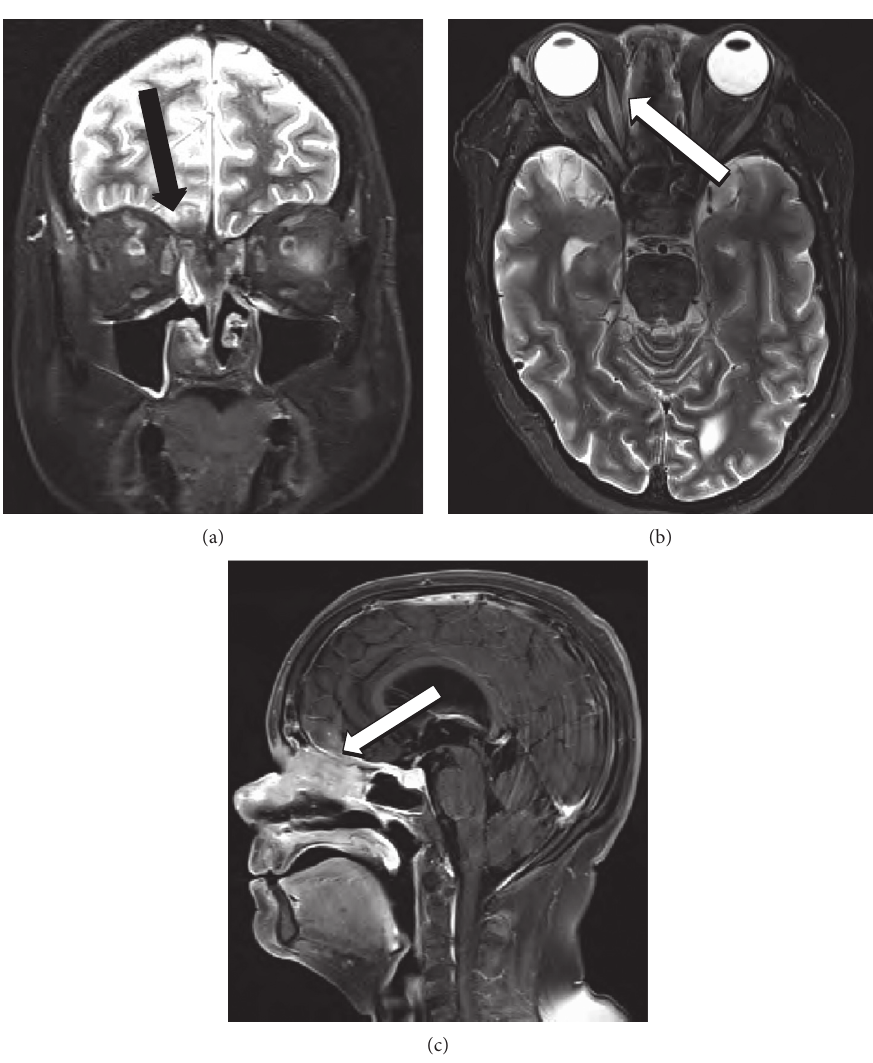
Figure 1: Triplanar MRI coronal STIR (a), axial STIR (b), and sagittal (c) T1-flair with fat saturation postcontrast showing midline anterior skull base mass with extension through skull base and right lamina papyracea (arrows) and saddle nose deformity